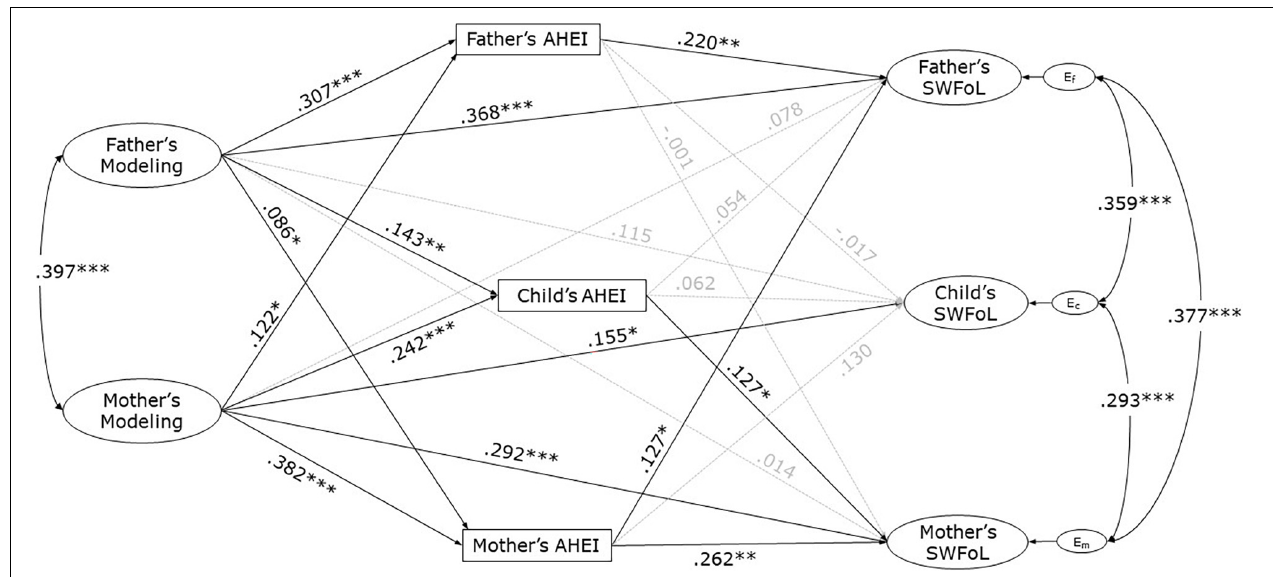
FIGURE 3 | Actor-partner interdependence model of the effect of both parents’ modeling on the three family members’ diet quality (measured by the Adapted Healthy Eating Index, AHEI) and Satisfaction with Food-related Life (SWFoL) in dual-earner parents with adolescent children. E f , E c and E m , residual errors on SWFoL for fathers, mothers and their adolescent children, respectively. ∗ p < 0.05, ∗∗ p < 0.01, ∗∗∗ p < 0.001. The control for the effects of family SES, number of children, parents’ and adolescents’ age, both parents’ number of working hours and type of employment, and times per week in which the family members had supper together on the dependent variables of the three family members (AHEI and SWFoL) were not shown in the path diagram to avoid cluttering the figure.